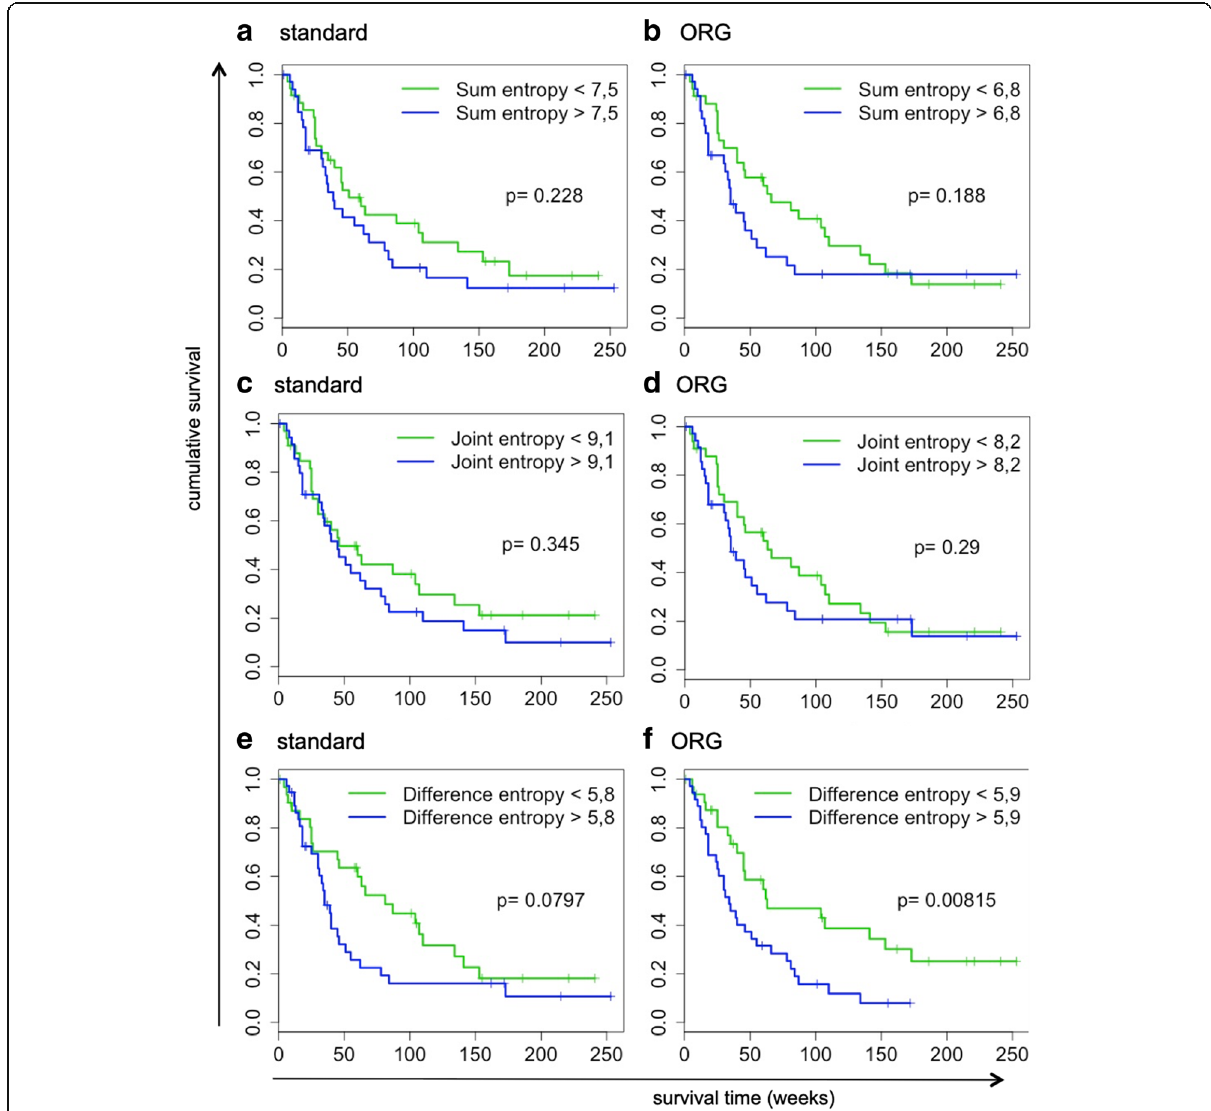
Fig. 5 Optimal respiratory gating impacts the correlation of [ 18 F]FDG PET-derived texture features with overall survival. Kaplan-Meier survival curves demonstrating the impact of compensation of respiratory motion on the correlation of PET-derived parameters with overall survival for PET-derived texture features, a – b sum entropy, c – d joint entropy, and e – f difference